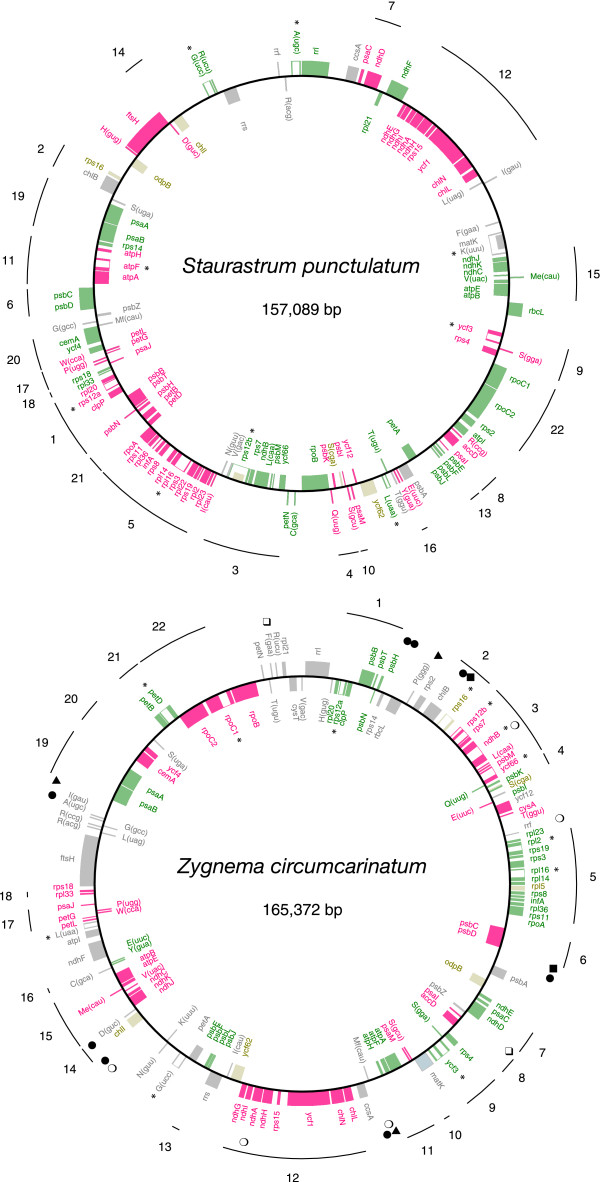
Gene maps of Staurastrum and Zygnema cpDNAs. Genes (filled boxes) shown on the outside of each map are transcribed in a clockwise direction, whereas those on the inside of each map are transcribed counterclockwise. Genes absent from Marchantia cpDNA are represented in beige. Gene clusters shared with Marchantia cpDNA [GenBank:NC_001319] are shown as alternating series of green and red boxes. Genes present in Marchantia cpDNA but located outside conserved clusters are shown in grey. Gene clusters shared by the two zygnematalean cpDNAs are represented by labelled bars outside each map. Genes containing introns (open boxes) are denoted by asterisks. Dispersed repeat regions in Zygnema cpDNA that contain short tandem repeats are denoted by symbols. The repeat units in these regions are as follows: filled squares, TAGAA; open squares, TTCTA; filled circles, GTAT; open circles, ATAC; filled triangles, CTTA. Note that filled and open symbols with the same geometric shape represent the repeat regions of which the sequences are in inverted orientation relative to one another. The intron sequences bordering the rps12 exons (rps12a and rps12b) are spliced in trans at the RNA level. tRNA genes are indicated by the one-letter amino acid code (Me, elongator methionine; Mf, initiator methionine) followed by the anticodon in parentheses. The ORFs unique to Staurastrum or Zygnema cpDNA are not indicated (see [GenBank:AY958085] and [GenBank:AY958086] for more details).